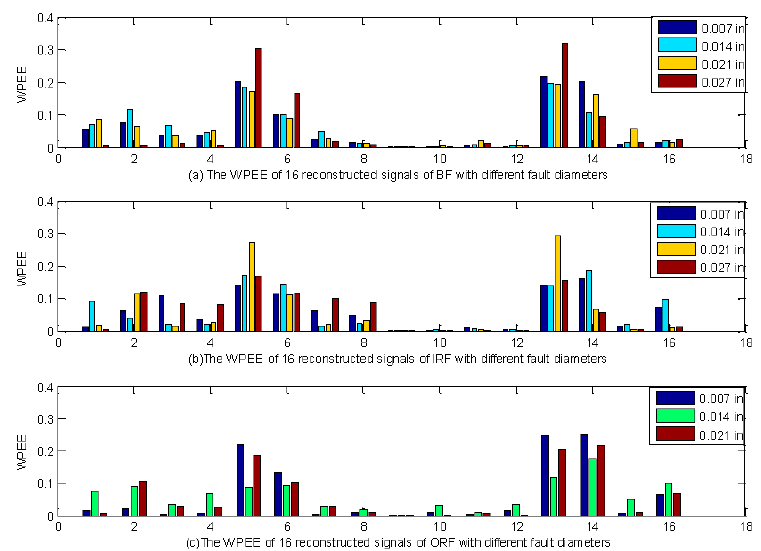
Figure 8. The WPEE feature extraction results under different fault types of rolling bearing with a load of 2 hp.